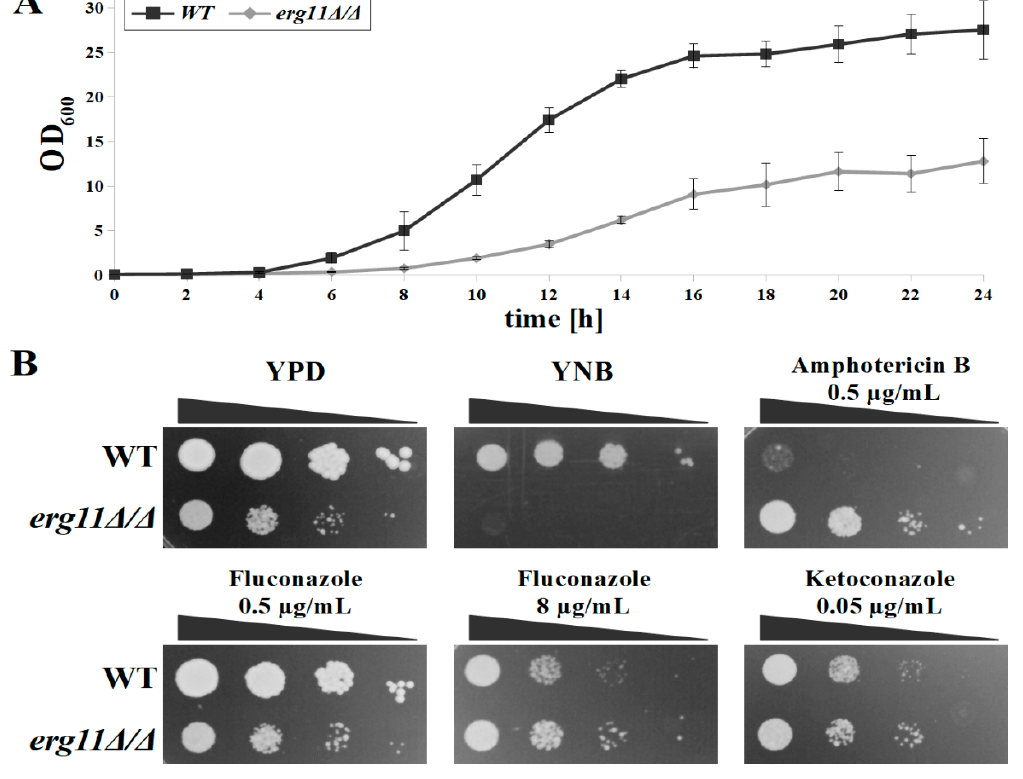
Figure 1. ( A ) Growth curves of C. albicans CAF2-1 wild type (WT) and KS028 ( erg11 ∆ / ∆ ) strains in (2% glucose, 1% peptone, 1% yeast extract (YE)) medium (28 ◦ C, 120 rpm); ( B ) Growth phenotypes of C. albicans CAF2-1 (WT) and KS028 ( erg11 ∆ / ∆ ) strains after 48 h incubation at 28 ◦ C. Growth